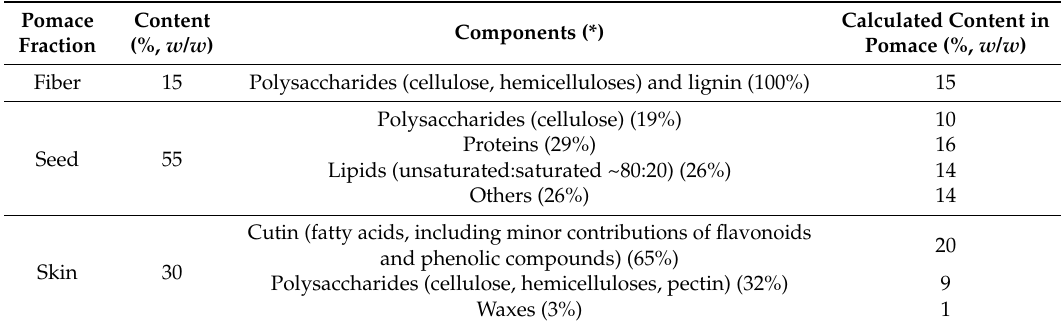
Table 1. Fraction and component content of tomato pomace